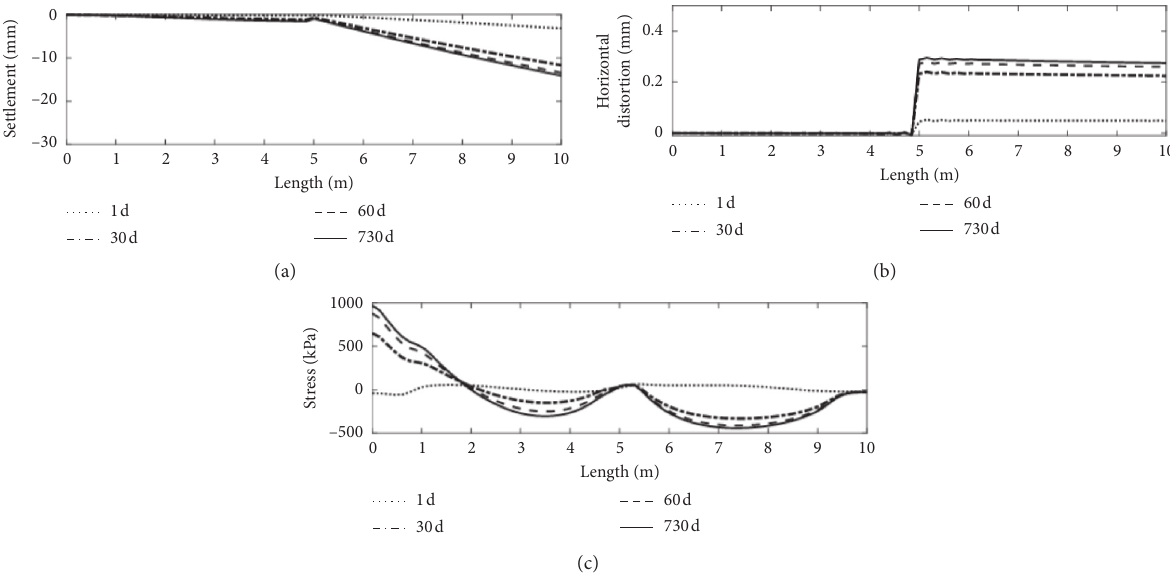
Figure 8: Lower partition slab simulation